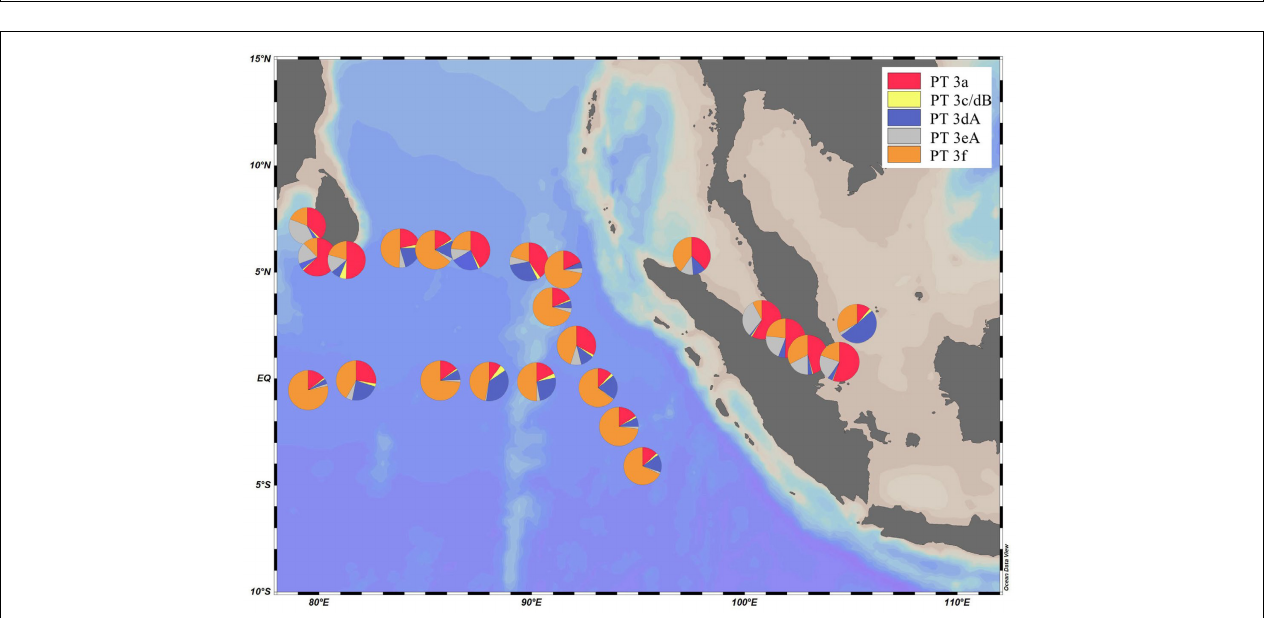
FIGURE 4 | Spatial distribution Synechococcus pigment types in the surface water of eastern Indian Ocean (EIO), coastal waters of Sri Lanka and the Strait of Malacca.